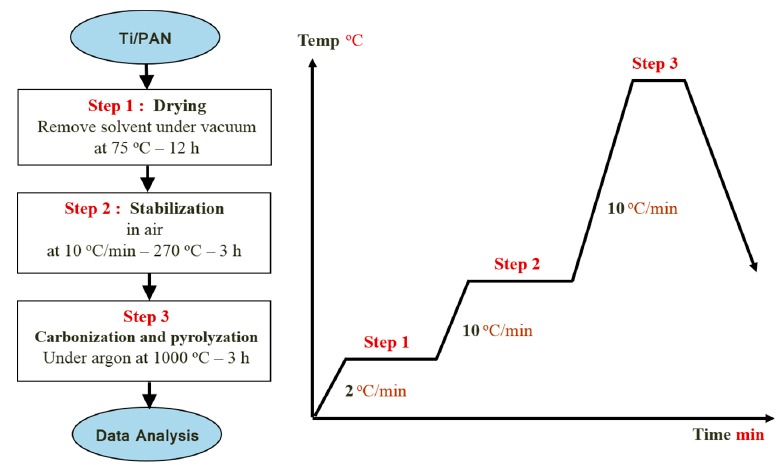
Figure 2. Drying and Calcination process for TiO 2 /PAN nanofibers mat.